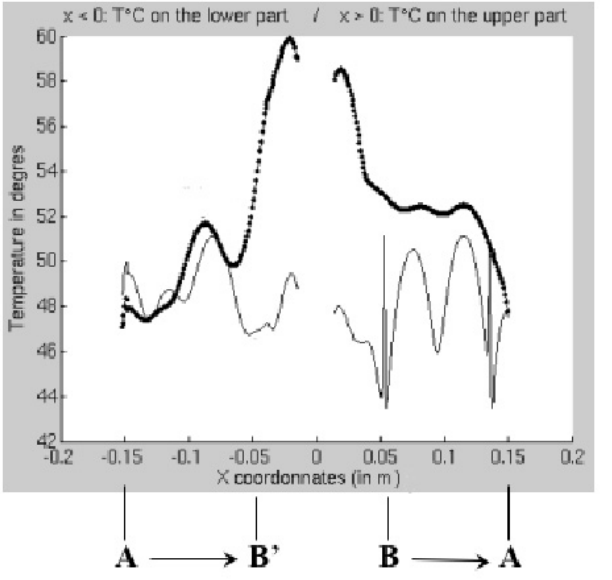
Fig. 9. Temperature measurements along the surface of the mold cavity before (black) and after (grey) optimization.